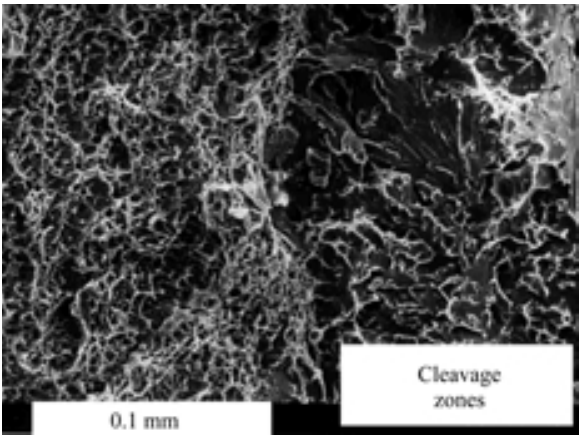
Figure 6b. Pop-in initiation point observed using a scanning microscope (specimen SE(T) 7 ).